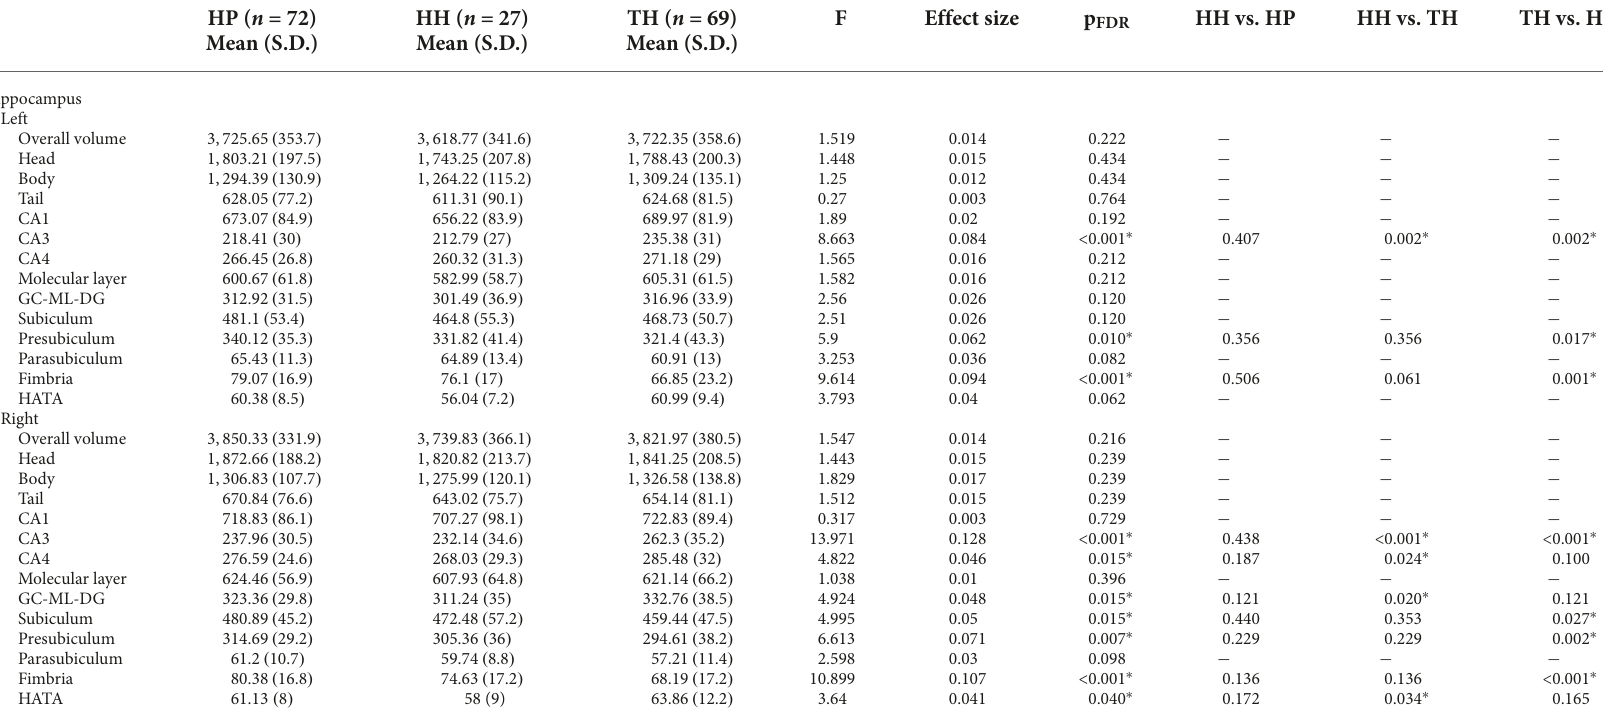
TABLE 2 Multivariate Analysis of Covariance (MANCOVA) and post hoc analysis of hippocampal volume in Tibetans (TH) and in Han Chinese individuals living at High Altitude (HH) or on the Plain (HP). HP ( n = 72) HH ( n = 27) TH ( n = 69) F Effect size p FDR HH vs. HP HH vs. TH TH vs. Mean (S.D.) Mean (S.D.) Mean (S.D.)